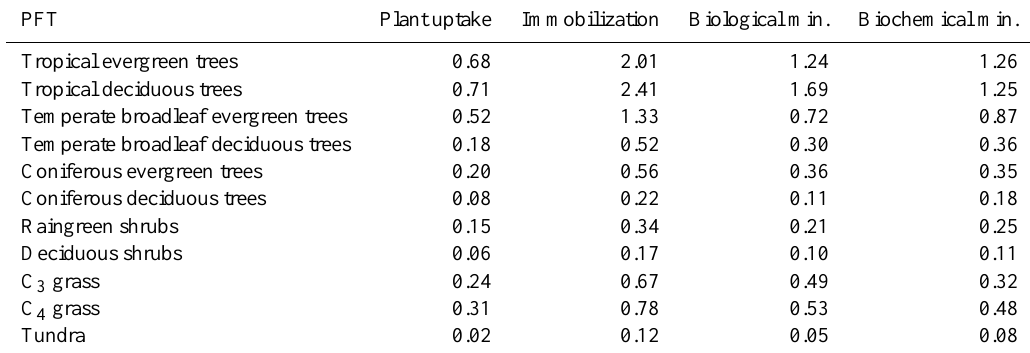
Table 7. Simulated P fluxes as means of PFT (g ( P ) m − 2 a − 1 ). The fluxes are averaged over the years 1970–1999. PFT Plant uptake Immobilization Biological min. Biochemical min. Tropical evergreen trees